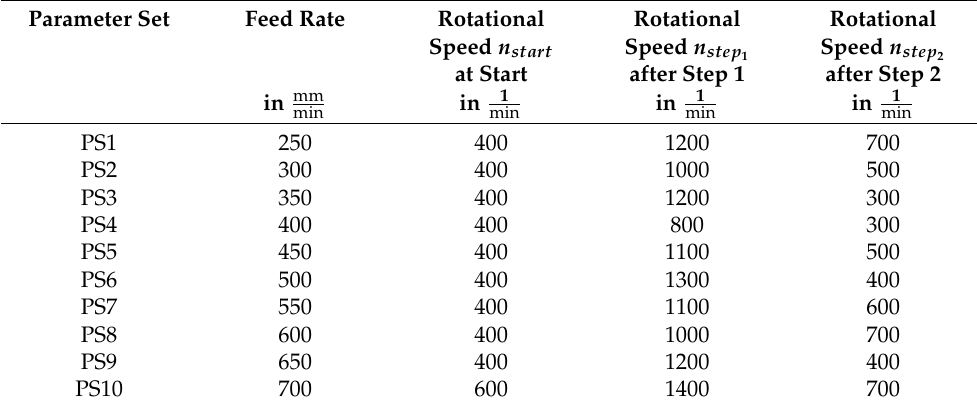
Table 1. Parameter sets (PS) for the system identification with a tilt angle α of 2°. Parameter Set Feed Rate Rotational Speed n start at